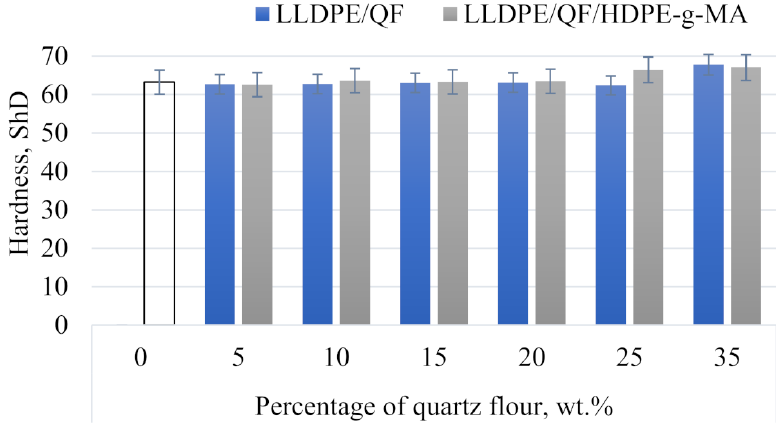
Figure 14. Shore hardness of LLDPE/QF and